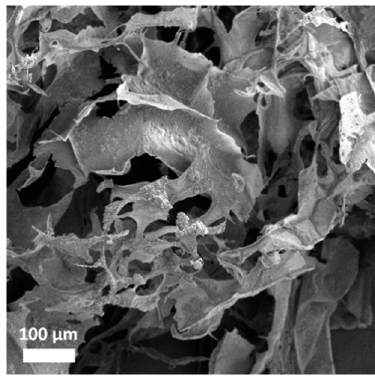
Figure 11. Microstructure of the collagen − polyphenols − loaded MSN − NH 2